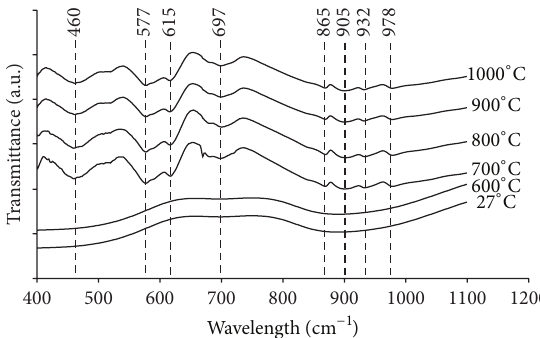
Figure 3: Fourier transforms infrared spectra of the sample at various heat treatment